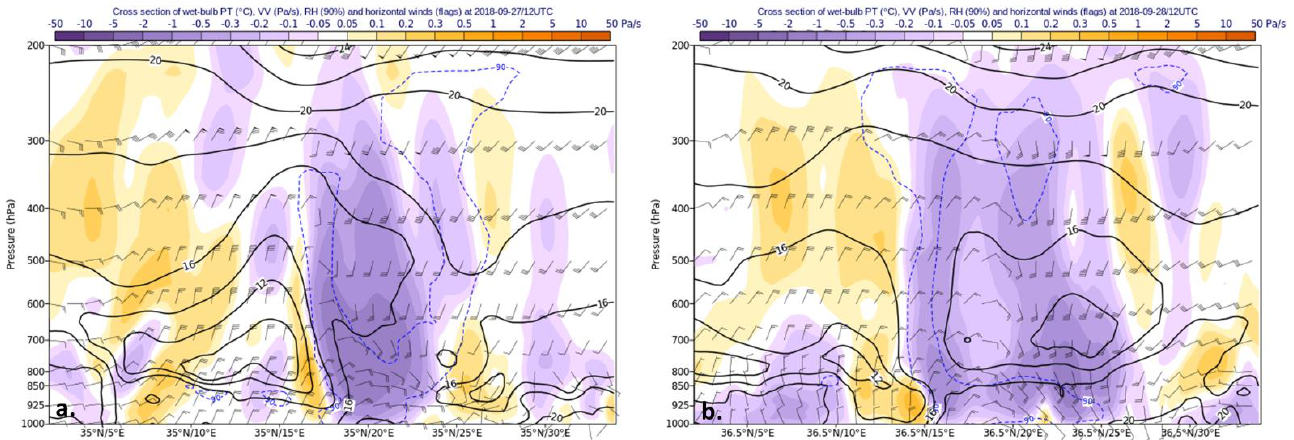
Figure 13. Cross-sections of wet-bulb potential temperature (isopleths), vertical velocity (ω) (coloured areas, in Pa/s, and horizontal wind (flags) following the cyclonic centre at ( a ) 27/12 UTC and ( b ) 28/12 UTC. Dashed blue lines represent the relative humidity value of 90%.